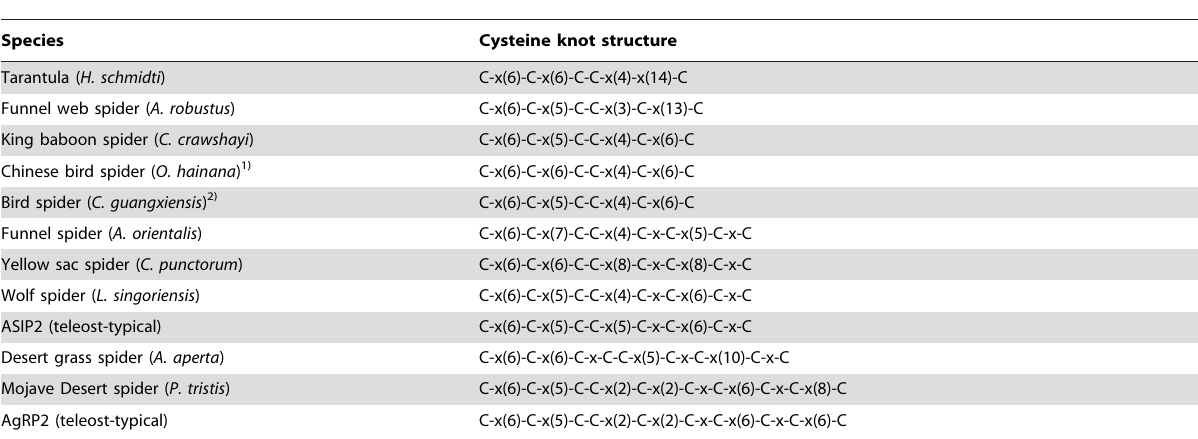
Table 1. Cysteine knots in spider toxins.